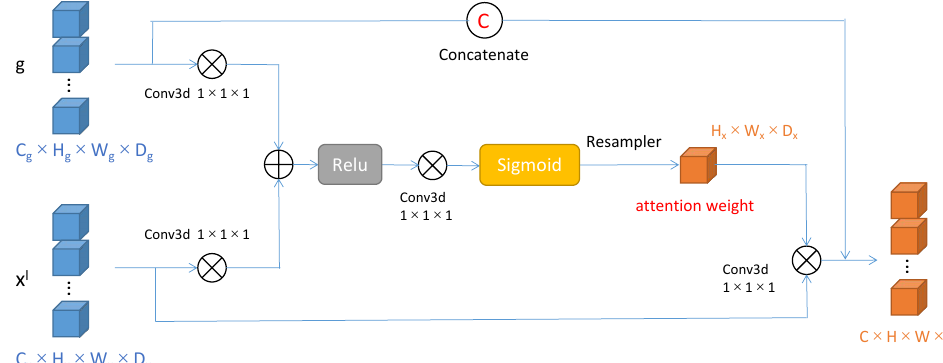
Figure 2. 3D attention